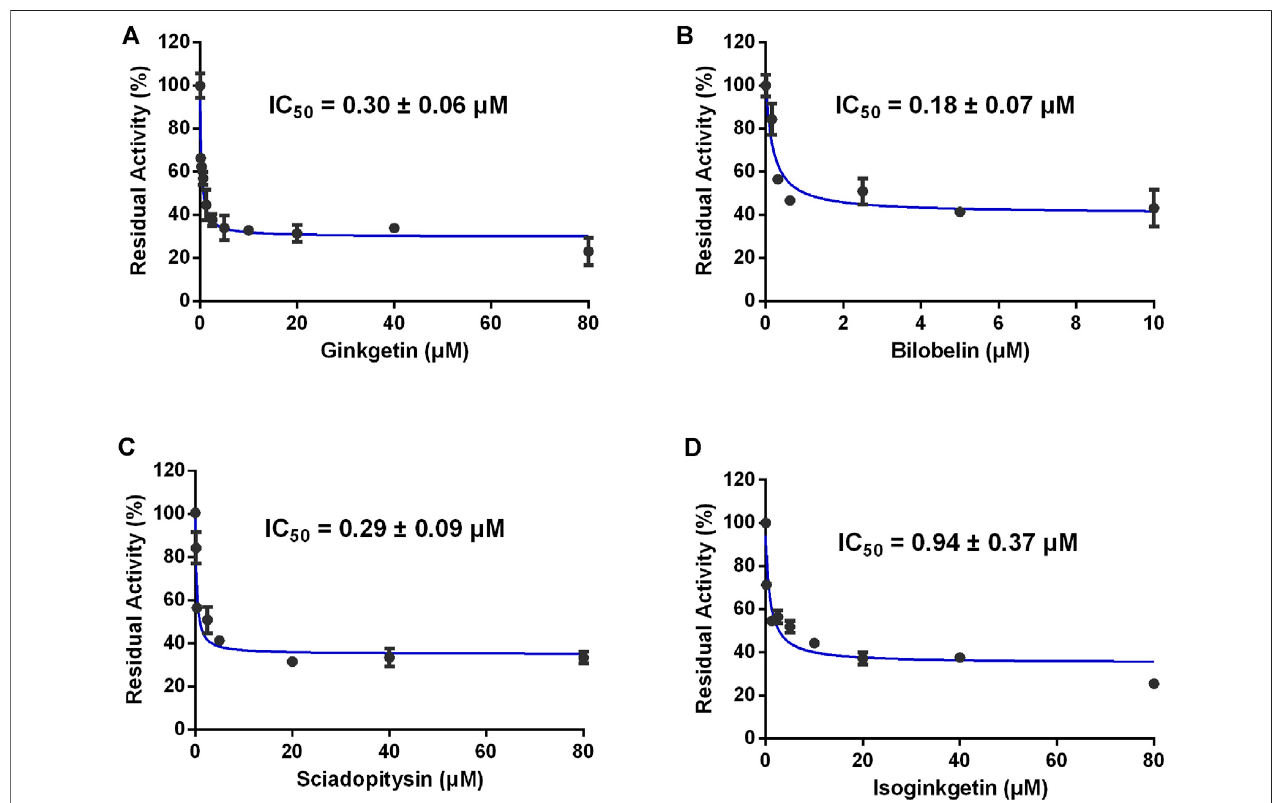
FIGURE 5 | Dose-inhibition curves of ginkgetin (A) , bilobetin (B) , sciadopitysin (C) and isoginkgetin (D) on CES2 using CPT-11 as the probe substrate in HIMs. All data were shown as mean ± SD of triplicate assays.